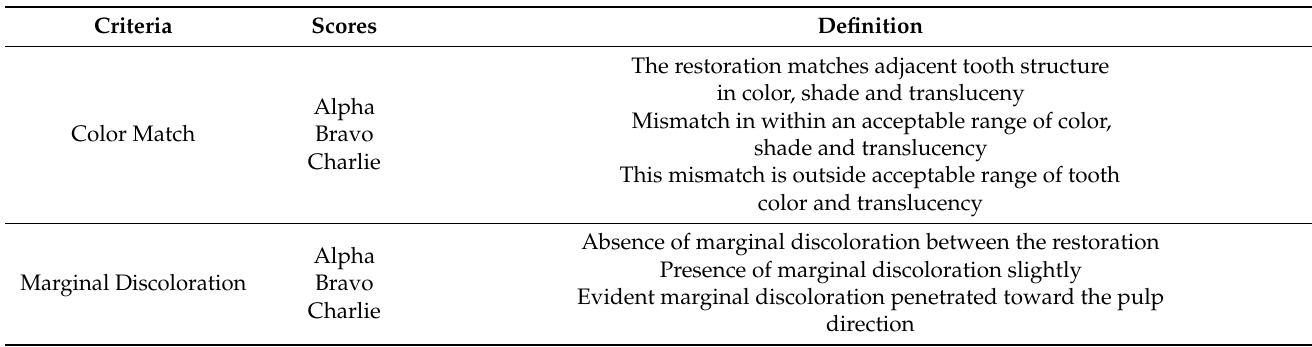
Table 2. Modified Ryge evaluation